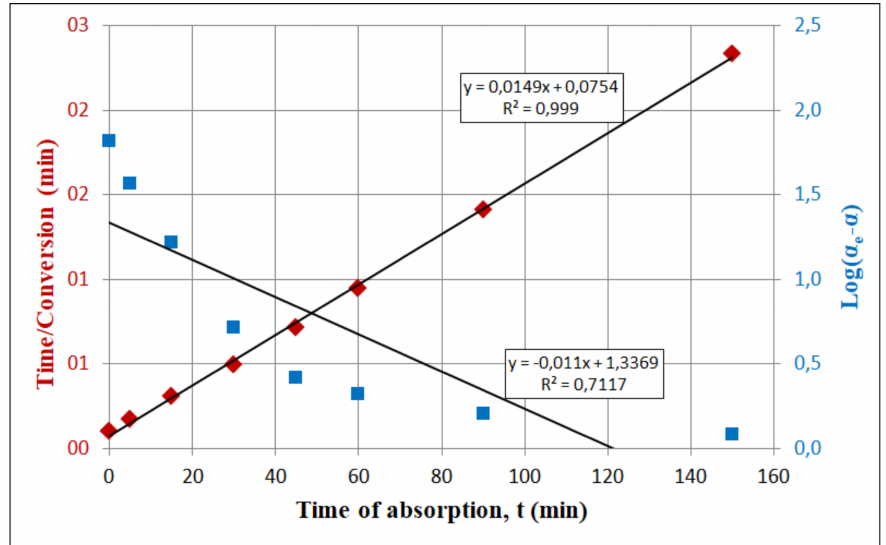
Figure 7. Linearized equation of the pseudo-first (right axis) and pseudo-second (left axis) order kinetics